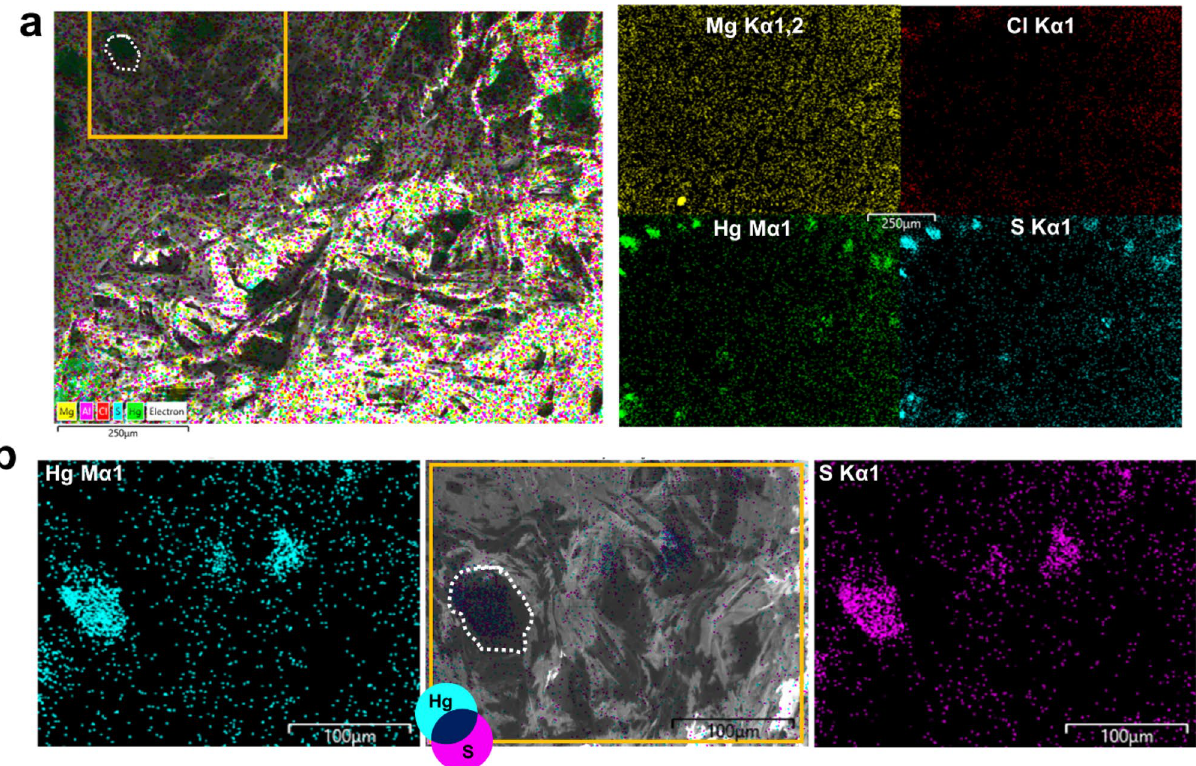
Figure 5. EDX elemental maps from the region medium‑dark . ( a ) Elemental maps of Mg, Cl, Hg and S. Note that sulfur and mercury show the same spatial distribution. ( b ) Detail of a cavity and elemental map of mercury and sulfur, in this case the correspondence between the copresence of Hg and S with the shape of the cavities is well visible. The yellow rectangular shape and white dotted line highlight the same region and cavity.